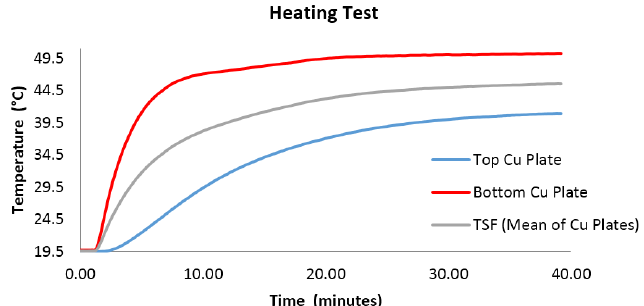
Figure 4. Heating temperature profiles of Cu plates and TSF.